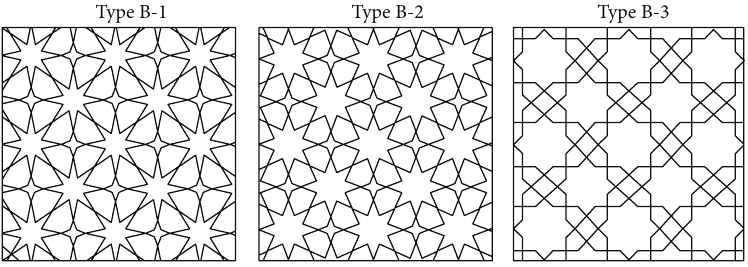
Figure 24: Type B patterning.